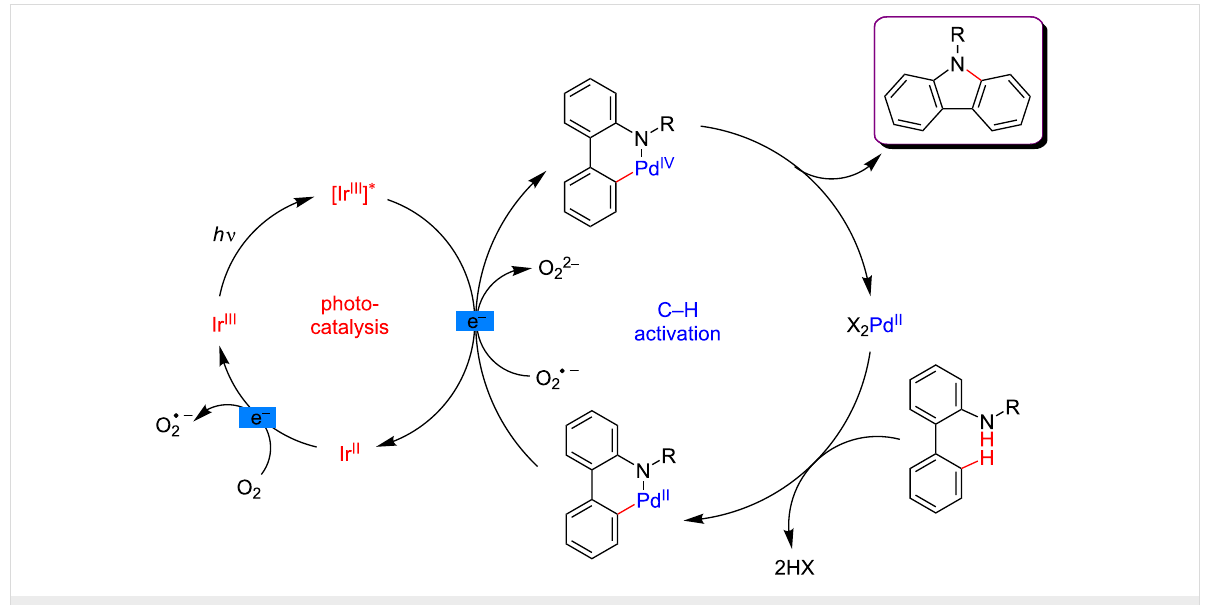
Figure 12: Proposed mechanism for the carbazole synthesis via dual